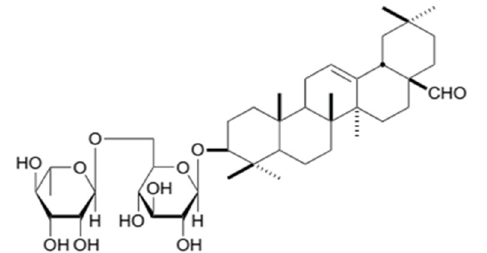
Figure 2. Molecular structure of saponin from the Sapindus rarak DC . extract [20].